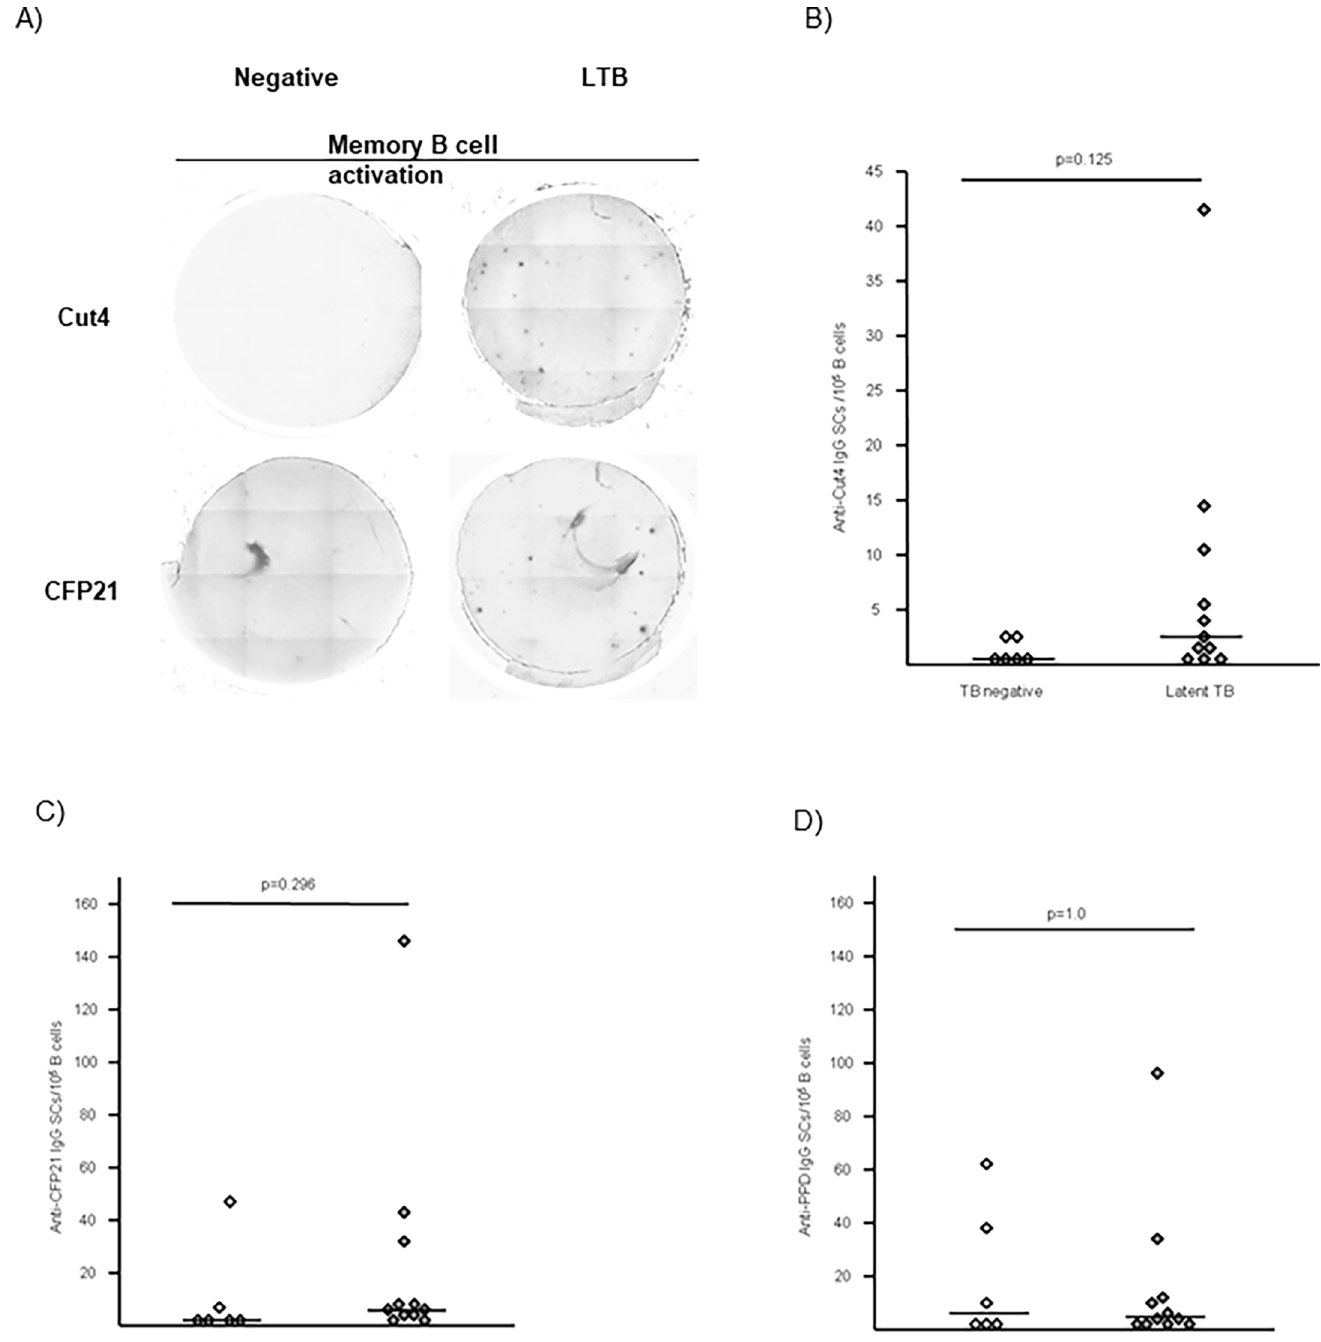
Fig 2. Anti-Cut4 and anti-CFP21 memory B cells. (A) Anti-Cut4 and anti-CFP21 ASCs after polyclonal stimulation from representative subjects of the Mtb uninfected and LTB groups, 1.105 enriched B cells were seeded per well. Quantification of ASC after five days of culture, anti-Cut4 IgG (B) and anti-CFP21 IgG (C) in Mtb uninfected and LTB subjects. The median values have been drawn as horizontal lines. Values of Wilcoxon Mann Withney tests are